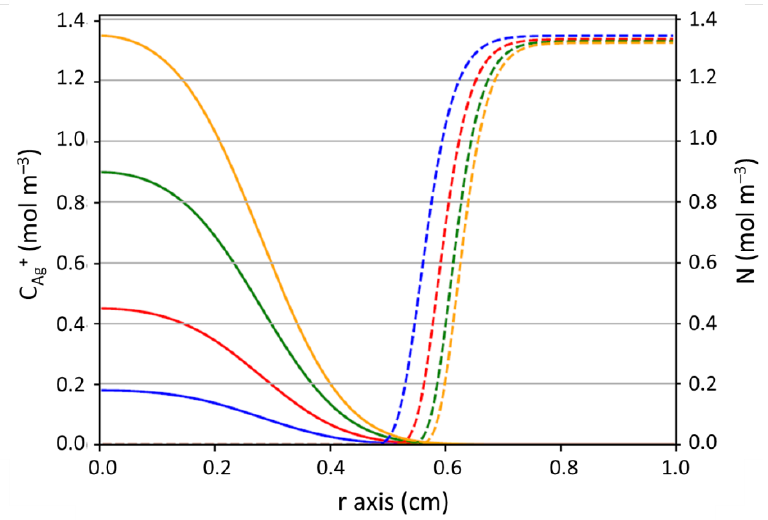
Figure 11. Concentration profiles after 24 h of contact (full lines: Ag + , i.e., C Ag+ ; dotted lines: E.coli bacteria, i.e., N). Blue curve: C Ag0+ = 20 mg L − 1 ; red curve: C Ag0+ = 50 mg L − 1 ; green curve: bacteria, i.e., N). Blue curve: C Ag0+ = 20 mg L −1 ; red curve: C Ag0+ = 50 mg L −1 ; green curve: C Ag0+ = 100 C Ag0+ = 100 mg L − 1 ; yellow curve: C Ag0+ = 150 mg L − 1 mg L −1 ; yellow curve: C Ag0+ = 150 mg L −1 .